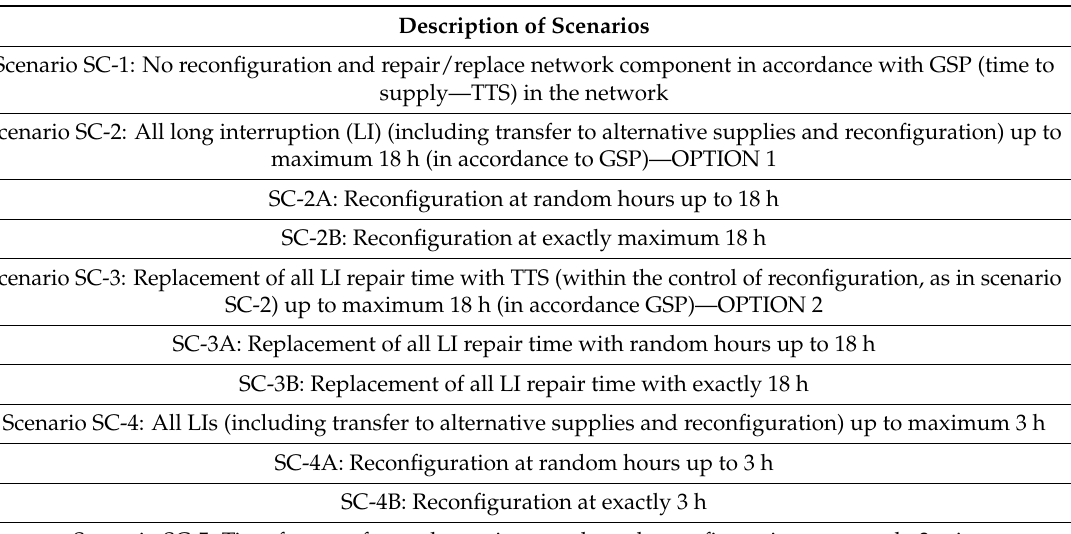
Table 5. Description of the Analysed Scenarios. Description of